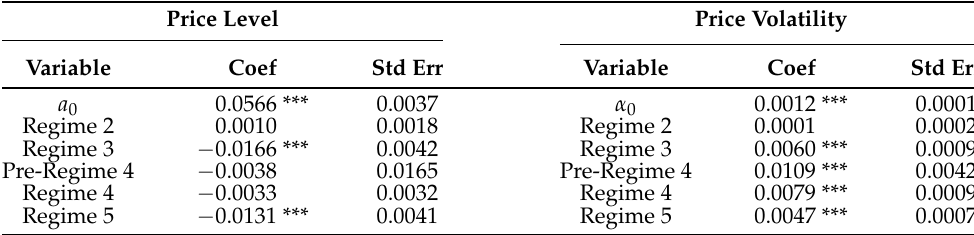
Table 5. Analysis of the impact of regulatory